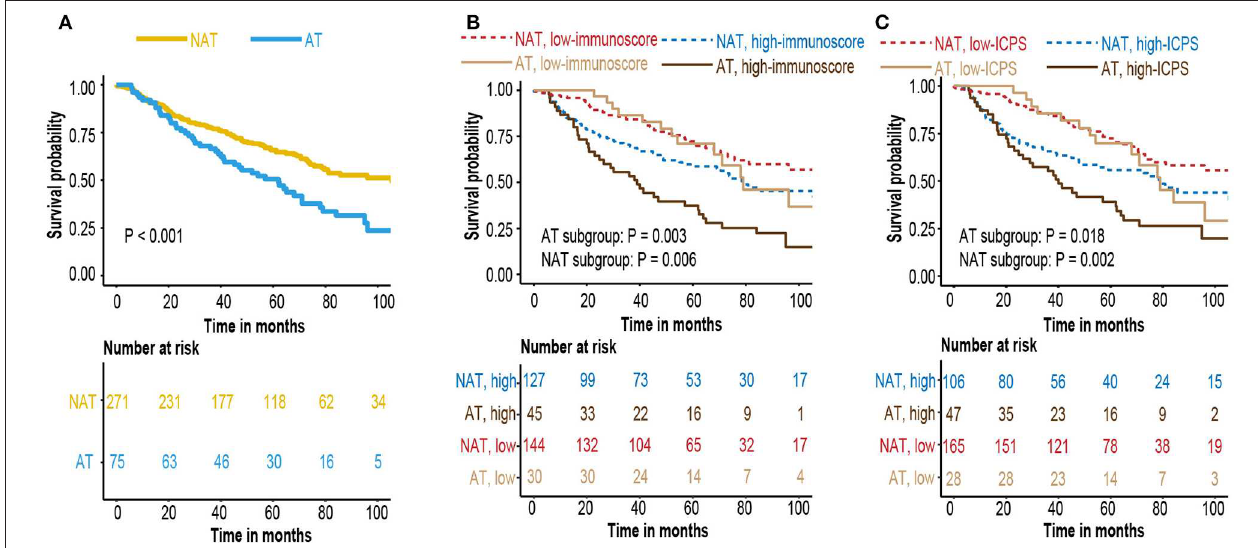
FIGURE 8 | (A) Kaplan–Meier curves for patients who received adjuvant therapy or not (B) Kaplan–Meier curves for survival prediction by the immunoscore in patients who received adjunctive therapy or not. (C) Kaplan–Meier curves for survival prediction by the ICPS in patients who received adjunctive therapy or not.